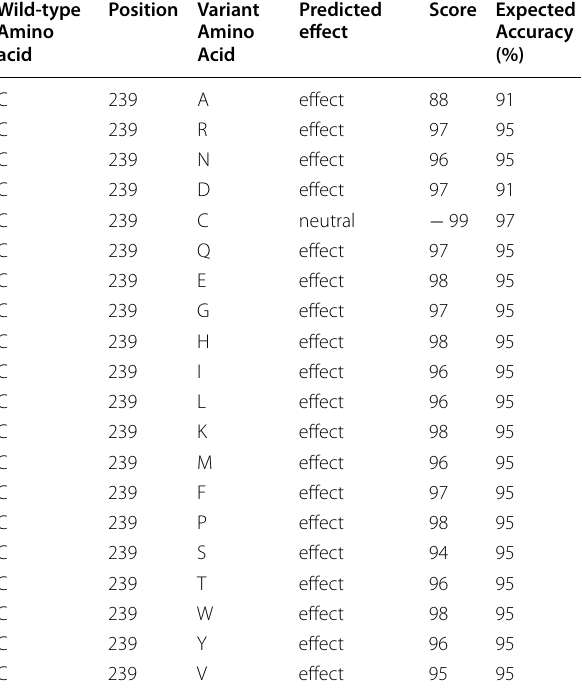
Table 1 The effect of amino acid substitution and the associated